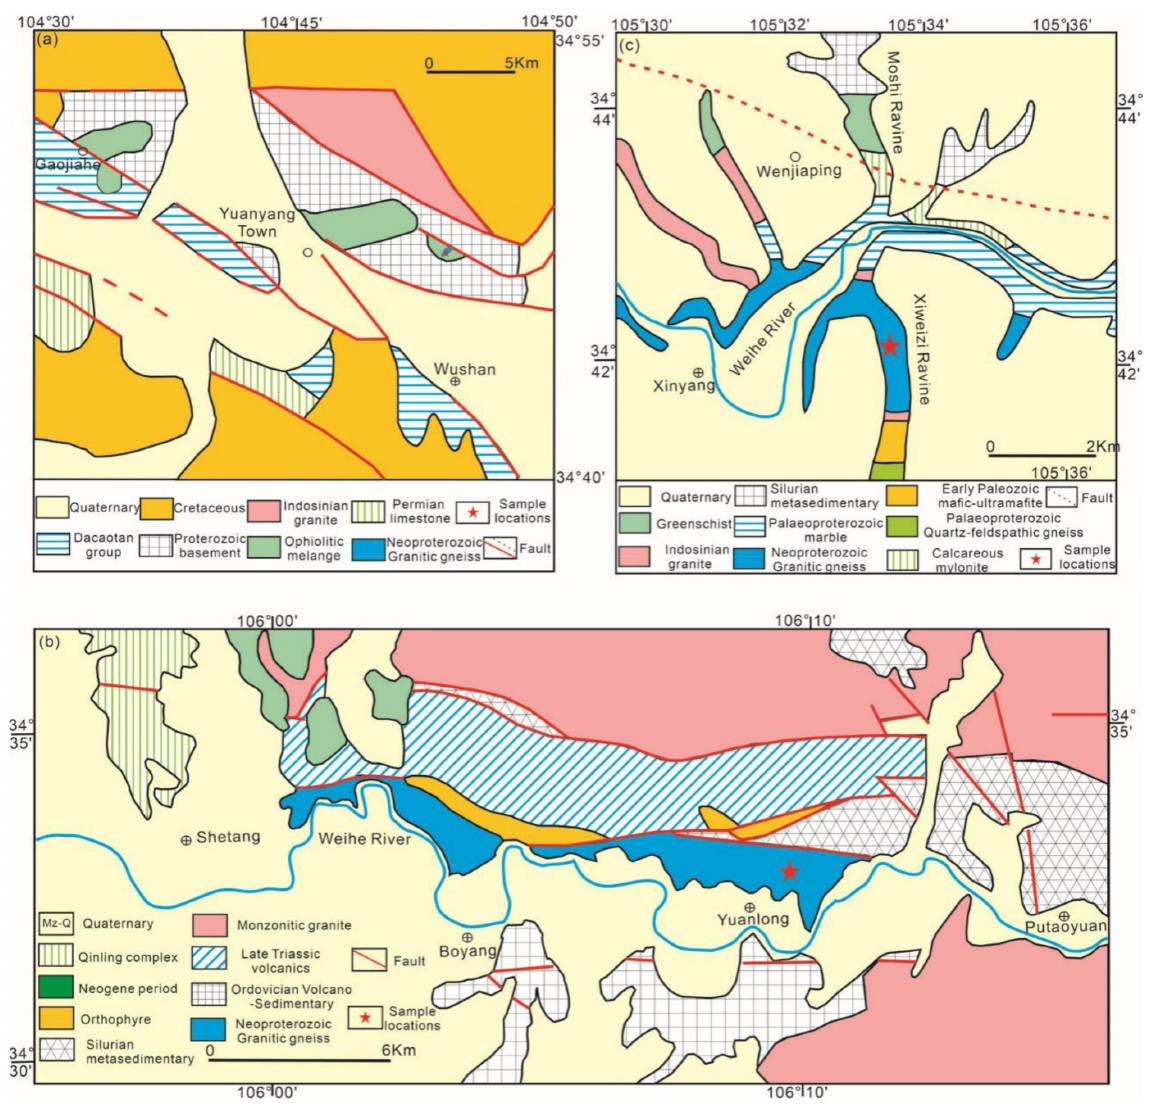
Figure 2. ( a ) Geological map of the Wushan area (modified after [26]); ( b ) geological map of the Yuanlong area (modified after [52]); ( c ) geological map of the Xinyang area (modified after